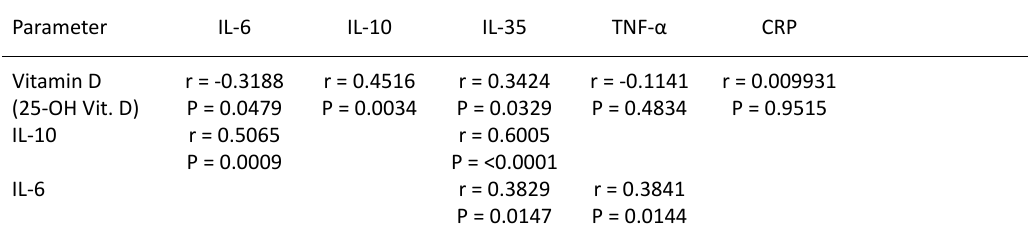
Table 3. Correlation investigation between parameters present in that study Parameter IL-6 IL-10 IL-35 TNF-α Vitamin